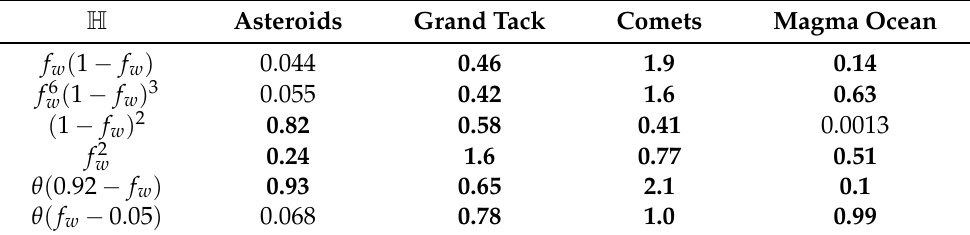
Table 2. Same as above, but with the nitrogen + area + Mg/Si condition. Values above 0.1 are displayed in